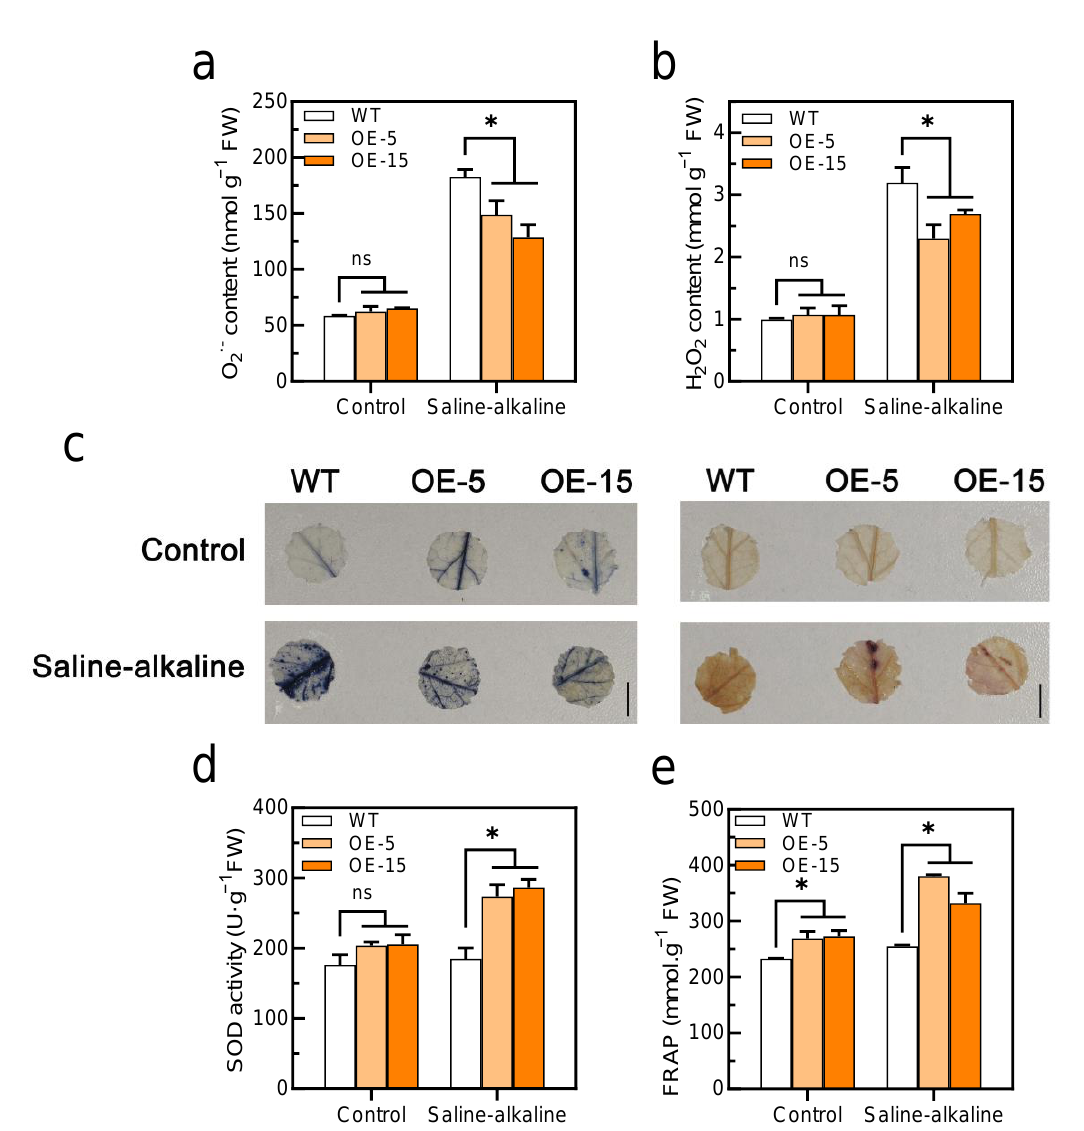
Figure 6. Overexpression of SlAREB1 confers enhanced the antioxidant capacity in transgenic tomatoes under saline–alkaline stress. ( a ) O 2 − and ( b ) H 2 O 2 contents after 7 d of treatment with 300 mM saline–alkaline mixed solution in wild-type (WT) and transgenic (OE-5 and OE-15) tomato seedlings. ( c ) In situ accumulation of O 2 − (blue) and H 2 O 2 (brown) of WT and transgenic tomatoes, as revealed by histochemical staining with nitro blue tetrazolium (NBT) and 3,3′ -diaminobenzidine (DAB), respectively, under saline–alkaline treatment. ( d ) SOD activity and ( e ) total antioxidant capacity (FRAP) in WT and transgenic tomatoes under saline–alkaline stress for 7 d. Distilled water was used as control. Values represent averages of four independent measurements, and error bars represent standard errors. Asterisks denote a significant difference compared with the control (* p < 0.05).